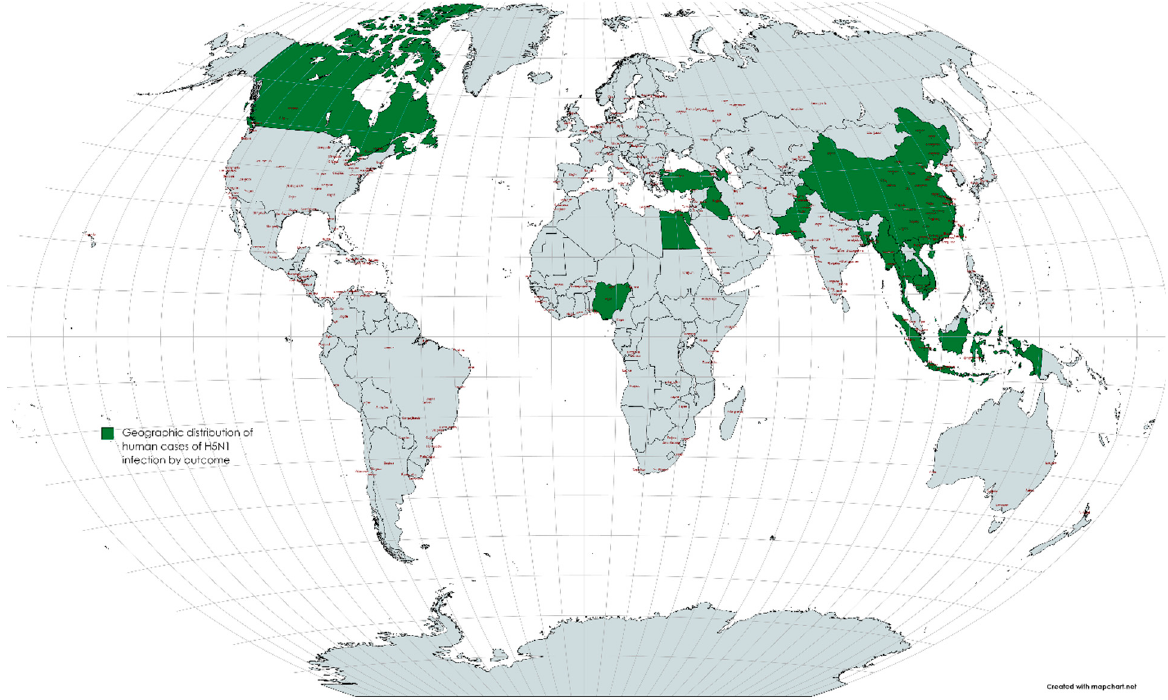
Figure 1. Geographic distribution of human cases of H5N1 infection by outcome, between May, 1997 to April, 2015.